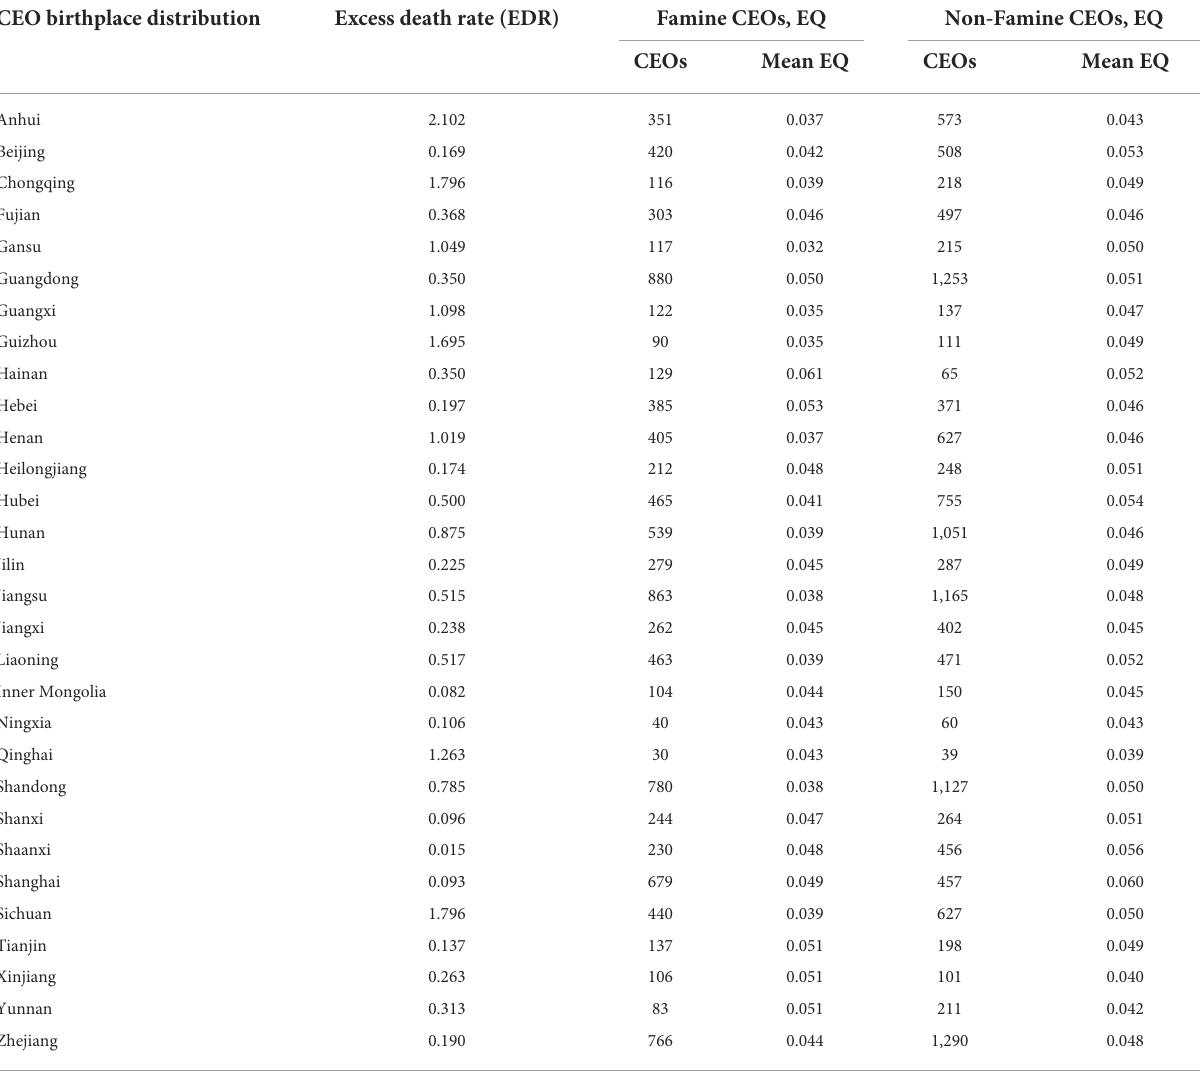
TABLE 2 Descriptive statistics of CEO birthplace distribution, excess death rate (EDR) for each province during the famine period and corporate earnings